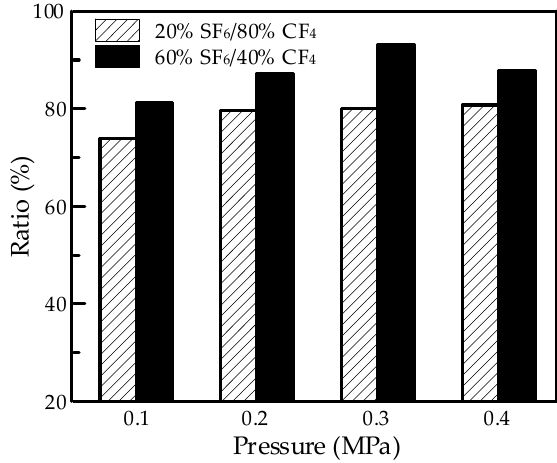
Figure 4. Flashover voltage ratio for various mixtures.